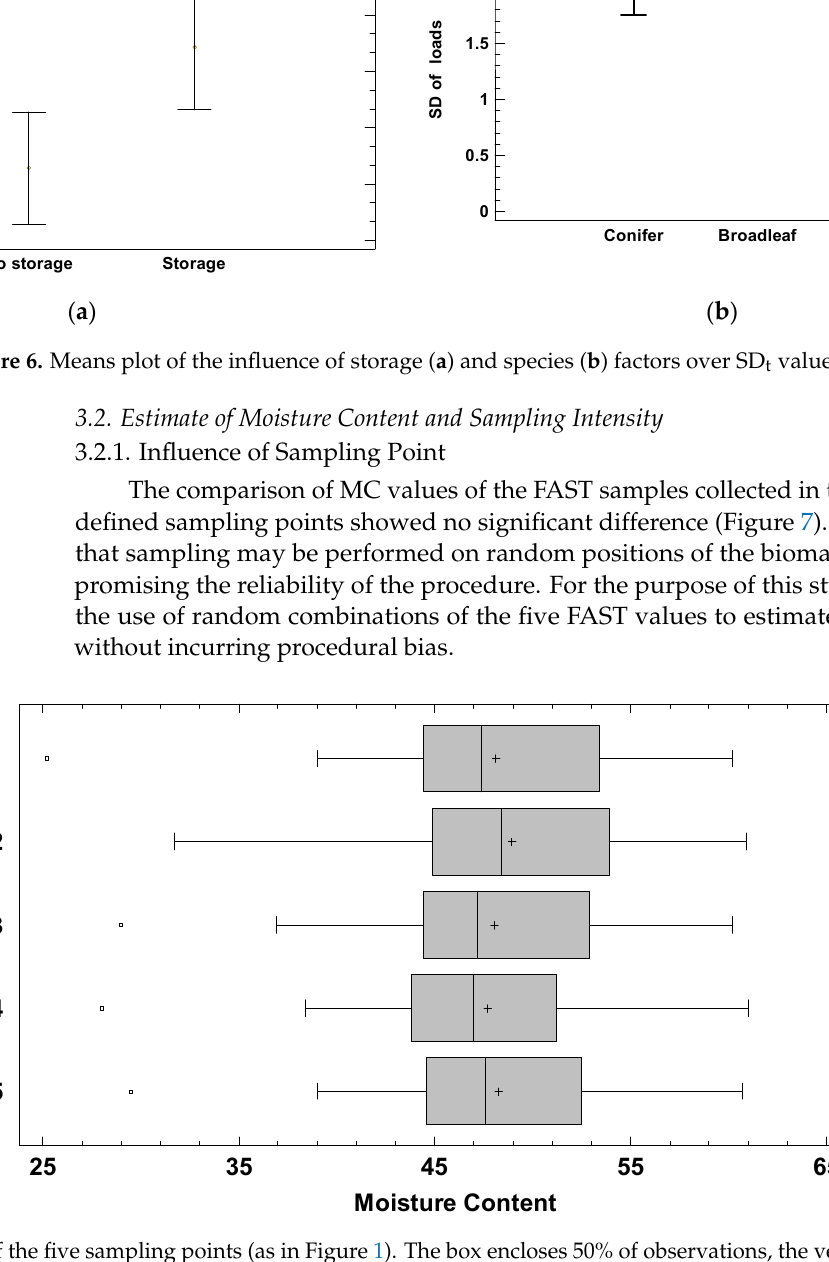
Figure 7. Box-plot of the five sampling points (as in Figure 1). The box encloses 50% of observations, the vertical line reports the median value and “+” indicates the average value.